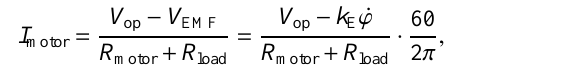
Figure 5. Initial state of the battery charging circuit.